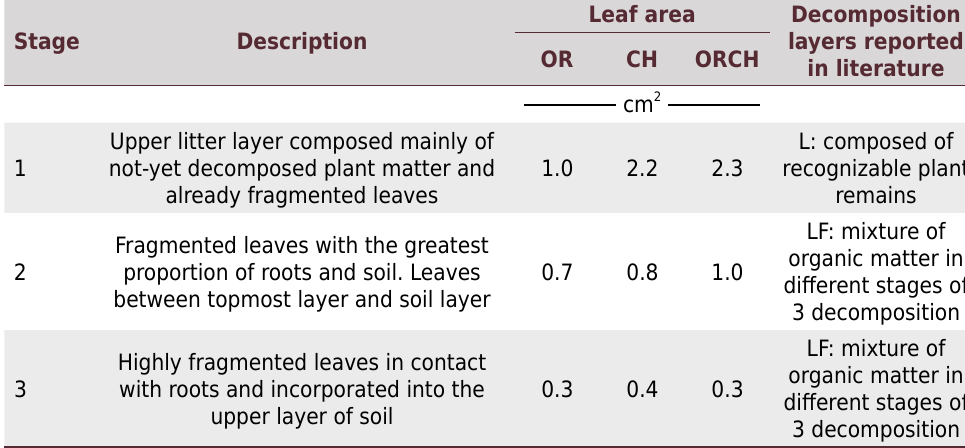
Table 1. Traits of three different stages of leaf litter decomposition within sampled plots